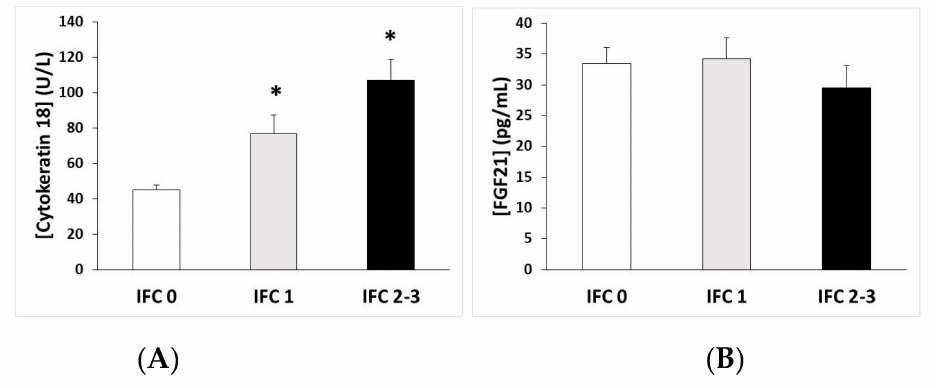
Figure 1. ( A ) Cytokeratin-18 and ( B ) fibroblast growth factor 21 (FGF21) plasma levels (mean ± SEM) according to the intrahepatic fat content (IFC). * p < 0.05 respect to IFC = 0 by a one-way